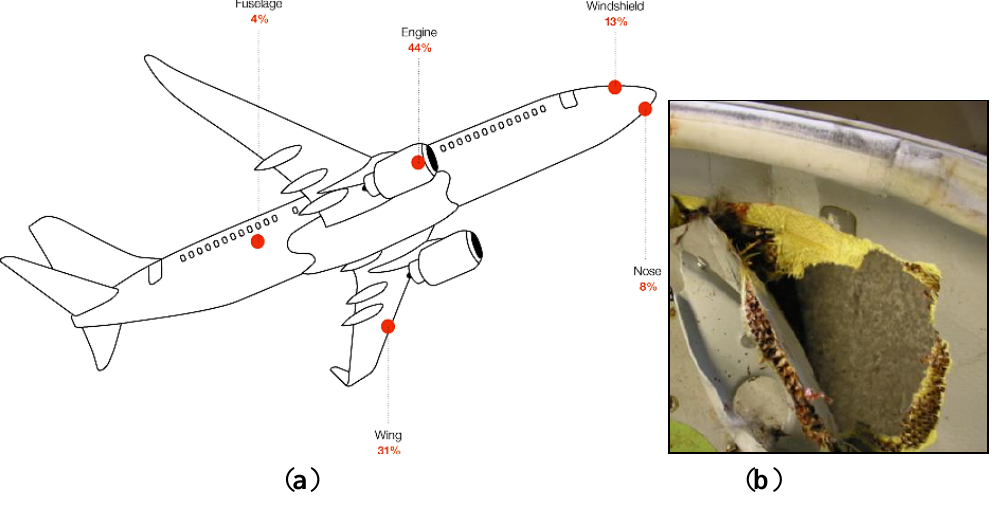
Figure 16. Bird strike impact probability ( a ); impact damage in a flap fairing of a cargo B767 caused by bird strike ( b